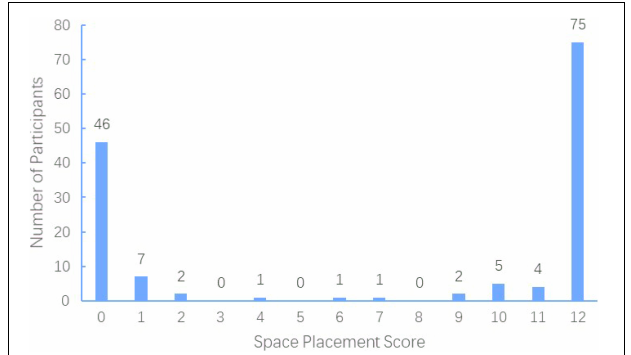
FIGURE 2 | Number of participants for different scores in spatial placement task. Score 12 and 0 could be identified as mode HLLR (HIGH SOCIAL STATUS-LEFT and LOW SOCIAL STATUS-RIGHT) and HRLL (HIGH SOCIAL STATUS-RIGHT and LOW SOCIAL STATUS-LEFT), respectively; Scores